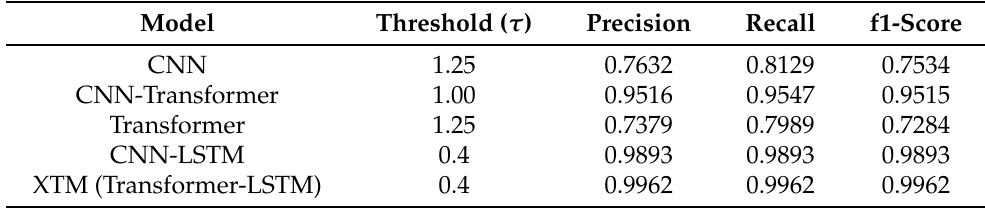
Table 6. Performance comparison for detecting the presence of FDI in IEEE-14 bus system.